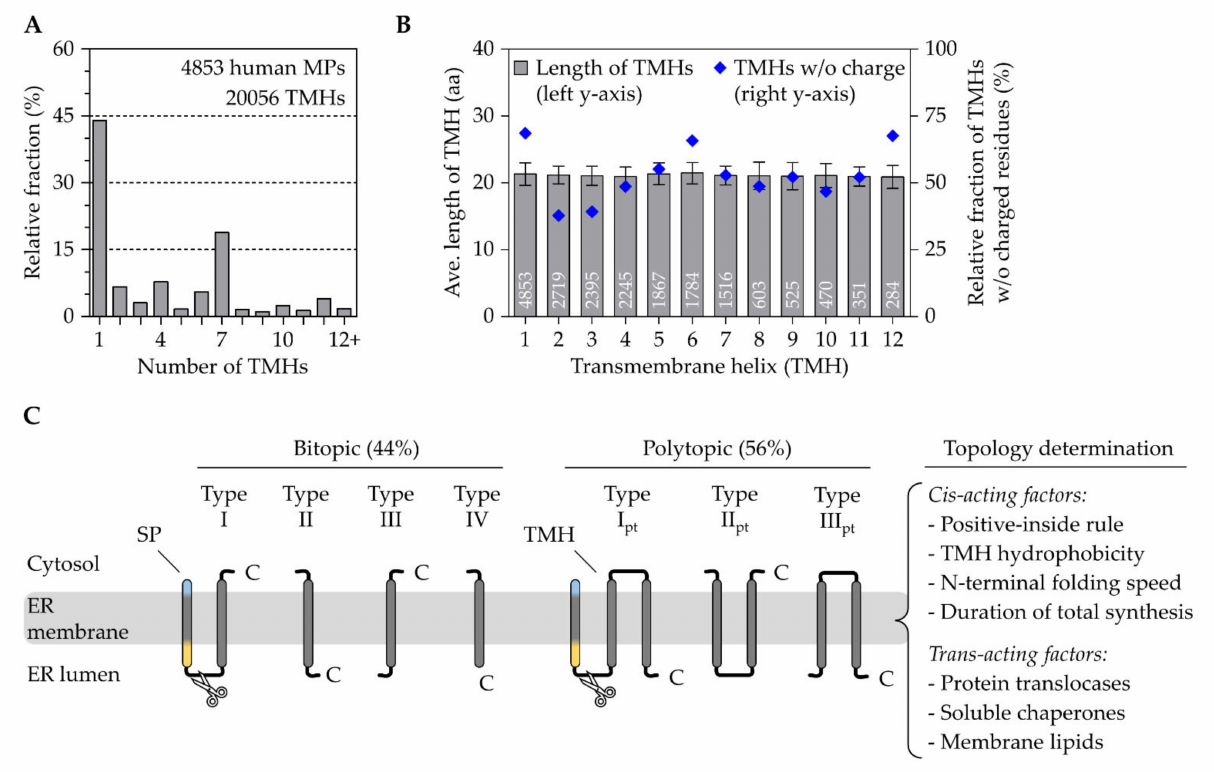
Figure 2. Length, charge, and topology of transmembrane helices of human bi- and polytopic membrane proteins. ( A ) The histogram shows the relative fraction of bitopic membrane proteins (MPs) with one transmembrane helix (TMH) and polytopic MPs with two or more TMHs. The data are based on the 20,056 TMHs of 4853 human MPs annotated at Uniprot. ( B ) Grey bars show the average length (left y-axis) with standard deviation of all first, second, and later TMHs till the twelfth TMH. White numbers at the bottom of the bar indicate the number of TMHs found in the human MPs. The blue diamond represents the relative fraction of the same TMHs that do not carry any charged residues (right y-axis). ( C ) Classification of bi- and polytopic ( pt ) membrane proteins